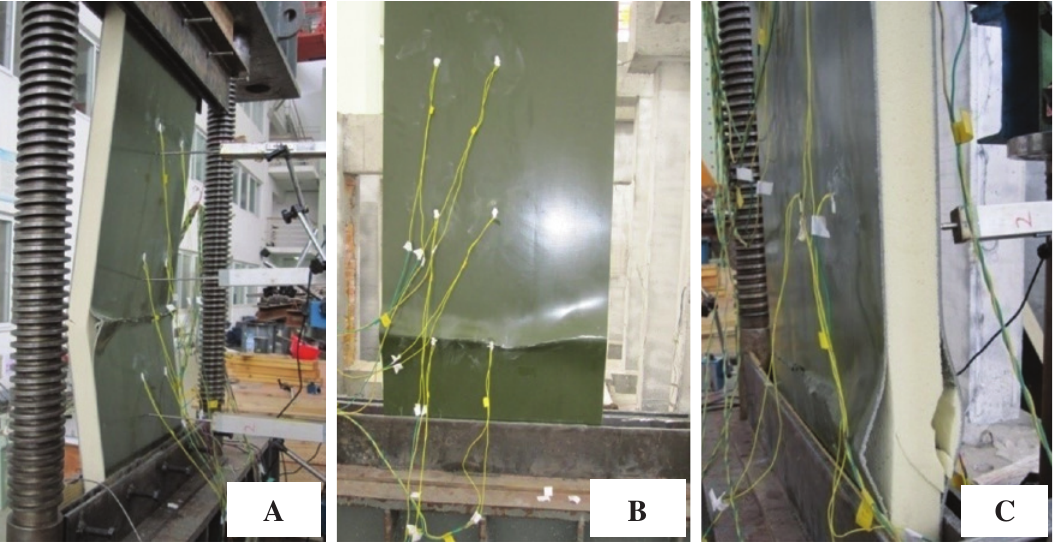
Figure 7: Failure modes: (A) delamination failure of Specimen WPC, (B) skin compressive failure of Specimen WP5, and (C) local buckling failure of Specimen